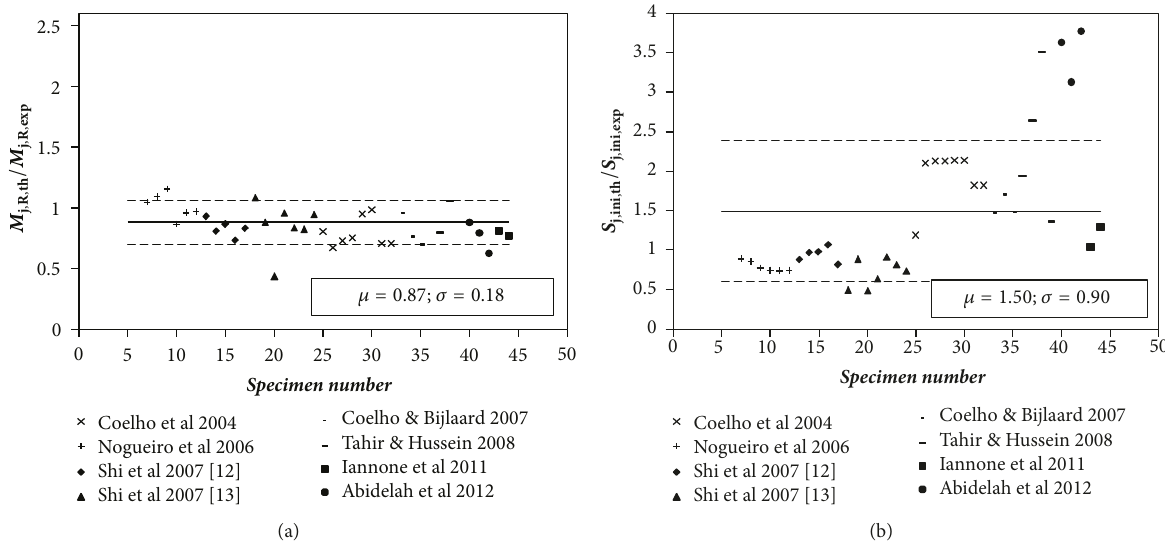
Figure 2: Ratios of theoretical to experimental moment resistance (a) and initial stiffness (b) for extended end-plate joints [7].